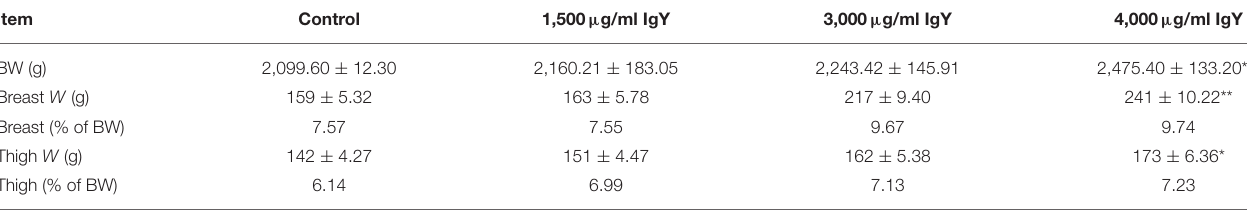
TABLE 5 | Weight of the breast and thigh (in grams and percent, relative to bird weight).